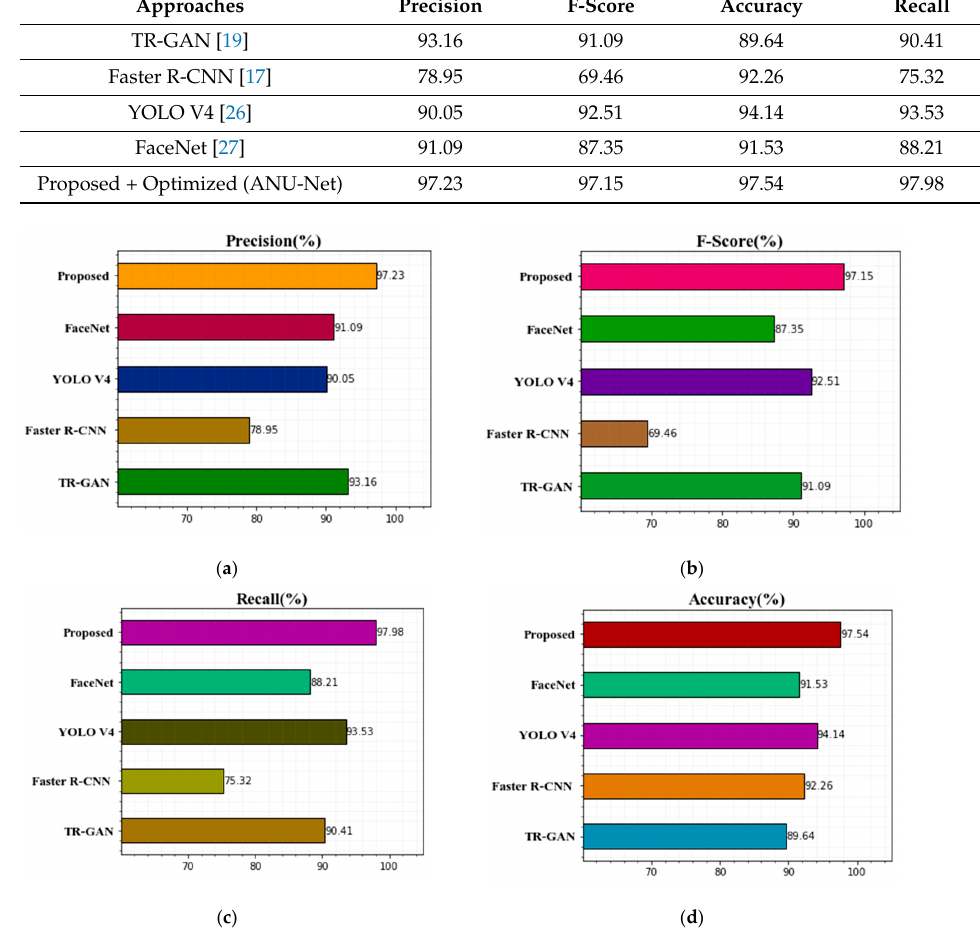
Table 4. Using the proposed and compared approaches, calculate precision, F-score, accuracy, and recall (%) while with optimization.